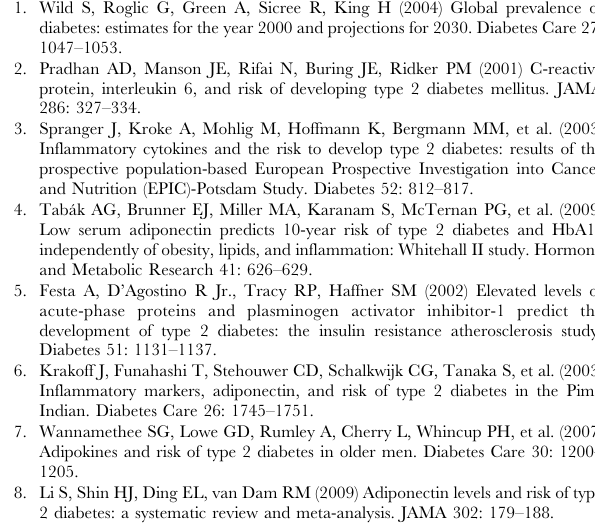
Table S2 Cytokine distribution between participants with (N =208) and without (N= 3634) incident diabetes. Table S3 Association between adipocytokine, hepatic or inflammatory marker levels (as continuous log-trans- formed variables) and incident type 2 diabetes. Table S4 Impact of adding different adipocytokine, hepatic or inflammatory markers (as continuous log- transformed variables) in the predictive capacity of a clinical + biological (C + B) risk score for type 2 diabetes. Table S5 Impact of adding different adipocytokine, hepatic or inflammatory markers as continuous log- transformed variables in the ability of a clinical + biological risk score to predict type 2 diabetes, using a 23% probability threshold to define high risk subjects. Table S6 Impact of adding specific combinations of adipocytokine, hepatic or inflammatory markers in the predictive capacity of a clinical + biological ( C + B ) risk score for type 2 diabetes, using a 23% probability threshold to define high risk